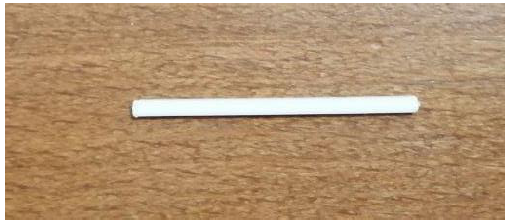
Figure 3. The beam configuration after 4D printing. Polymers 2020 , 12 , 519